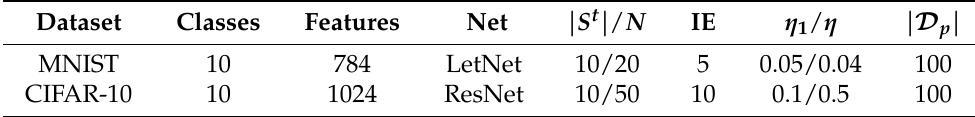
Table 2. Dataset description and